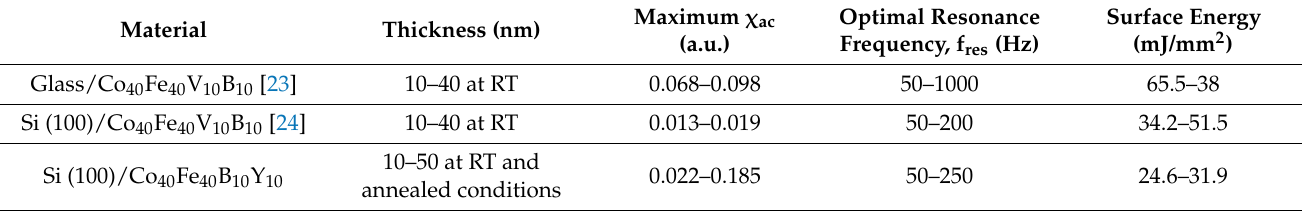
Table 1. Specific properties for various Glass/CoFeVB, Si (100)/CoFeVB, and Si (100)/CoFeBY materials.